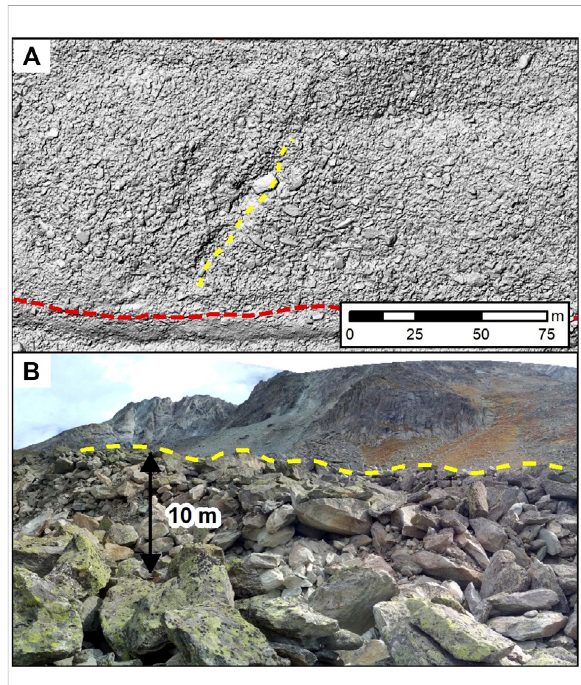
FIGURE 9 Illustration of the situation of the scarp during the last UAV survey. (A) Hillshade derived from the 24 September 2019 UAV survey showing the longitudinal extension of the scarp (yellow line). (B) Photograph acquired during the same day of the UAV survey (24 September 2019) indicates the vertical distance reached by the scarp